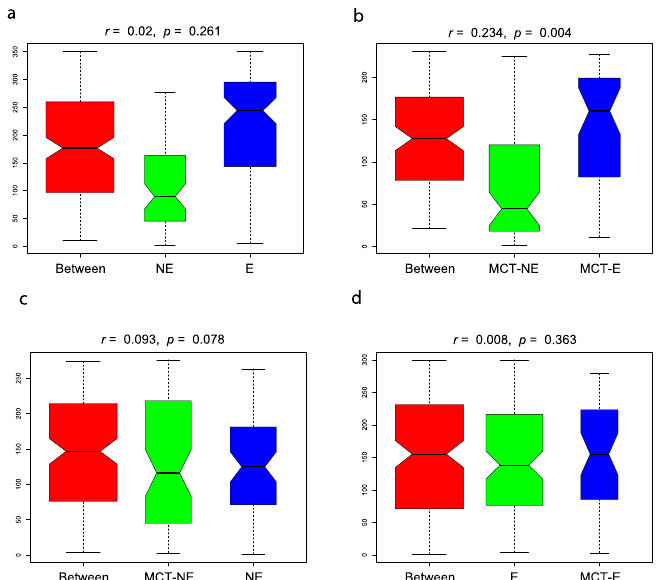
Figure 3. Analysis of similarity (Anosim) between epileptic (E) and non-epileptic (NE) dogs in baseline conditions (( a ): E vs. NE) (Anosim r = 0.002; p = 0.261), between E and NE dogs after the MCT diet (( b ): MCT-E vs. MCT-NE) (Anosim r = 0.234; p = 0.004), in NE dogs before and after the MCT diet (( c ): NE vs. MCT-NE) (Anosim r = 0.093; p = 0.078) and E dogs before and after the MCT diet (( d ): E vs. MCT-E) (Anosim r = 0.008; p = 0.363).